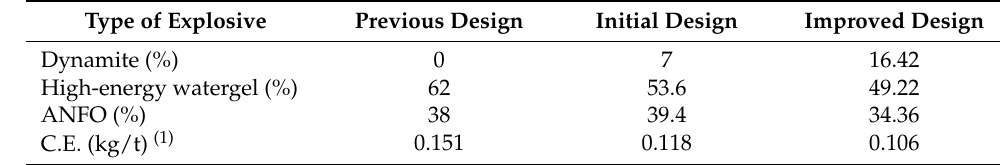
Table 2. Comparison of explosives used in the three types of